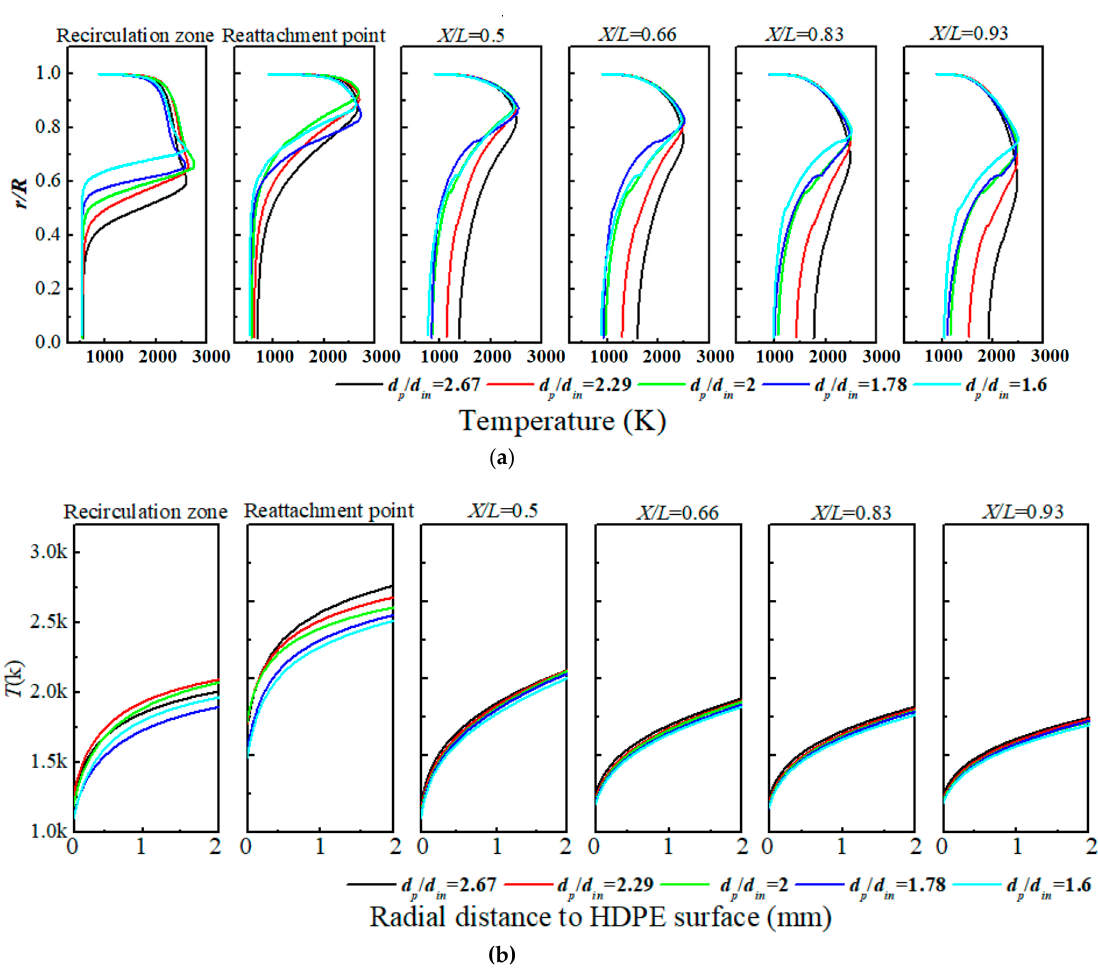
Figure 26. Temperature ( a ) and temperature around fuel surface ( b ) at different axial positions of different cases.